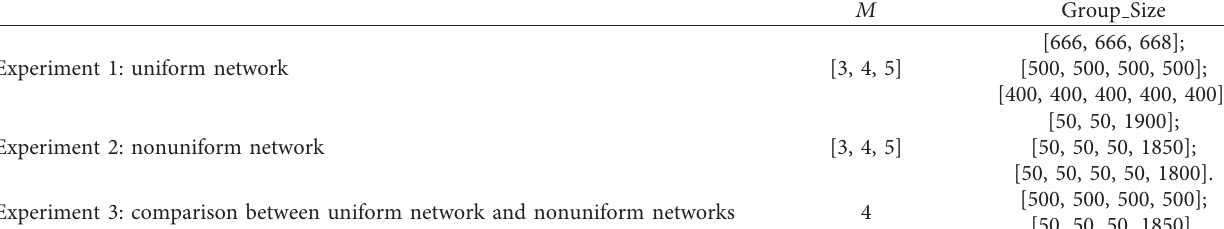
Table 10: Parameter setting of M and Group Size